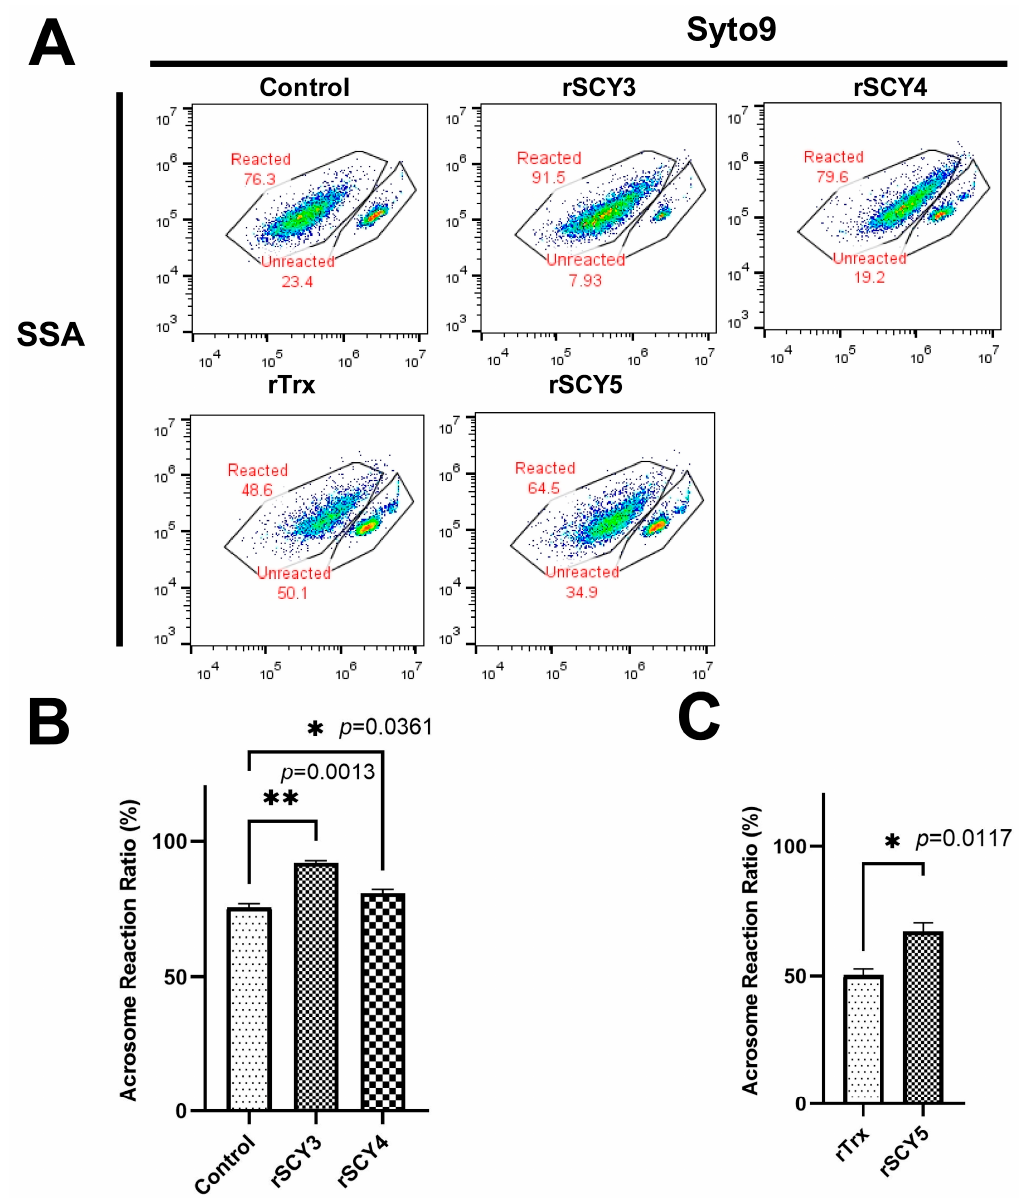
Figure 7. Flow cytometry analysis of the sperm % AR ( A ) and the quantification of changes after different treatments ( B , C ). The data shown are derived from a representative experiment reported as the mean (n = 2) ± SD. * p < 0.05; ** p < 0.01 (one-way ANOVA, repeated measurement).